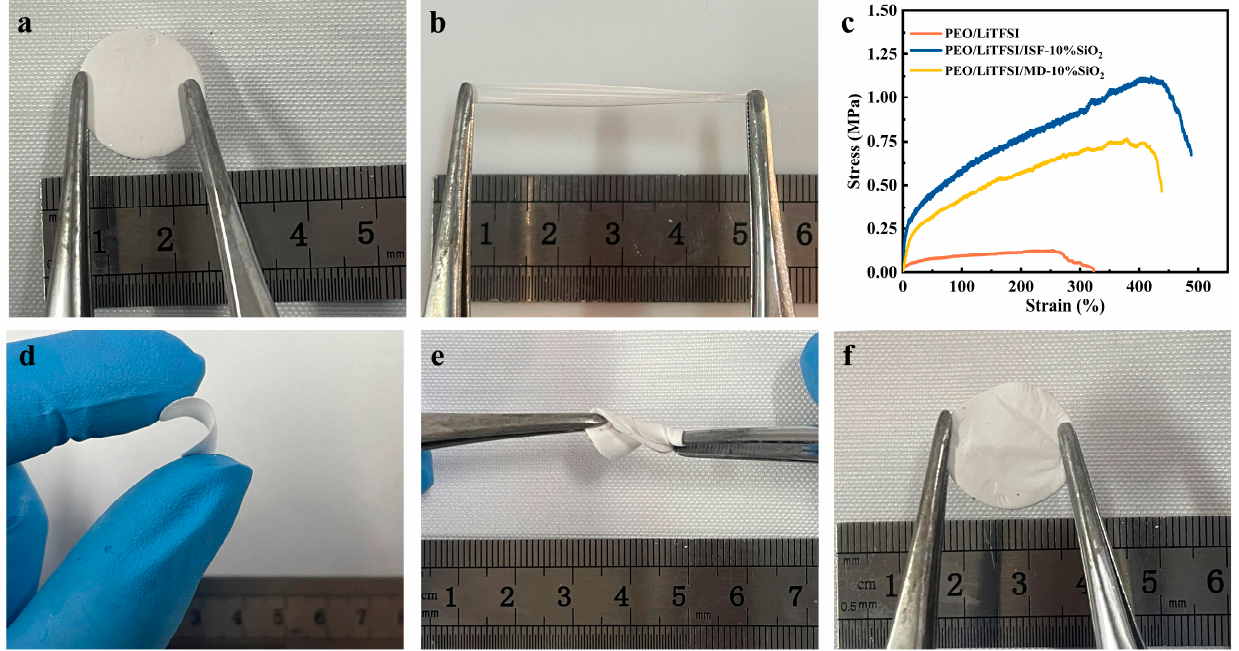
Figure 4. ( a ) Initial and ( b ) stretching appearance of PEO/LiTFSI/ISF-10%SiO 2 . ( c ) Stress–strain curves of the electrospun SPEs. ( d ) Bending, ( e ) torsion, and ( f ) recovery appearance after torsion of PEO/LiTFSI/ISF-10%SiO 2